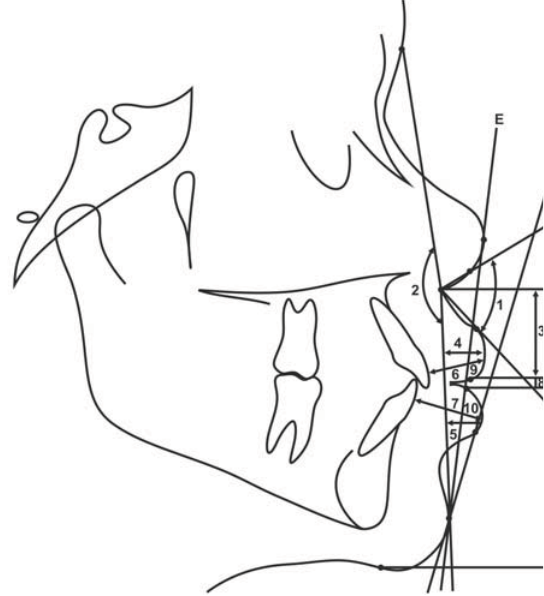
Figure 2- Less usual cephalometric variables: